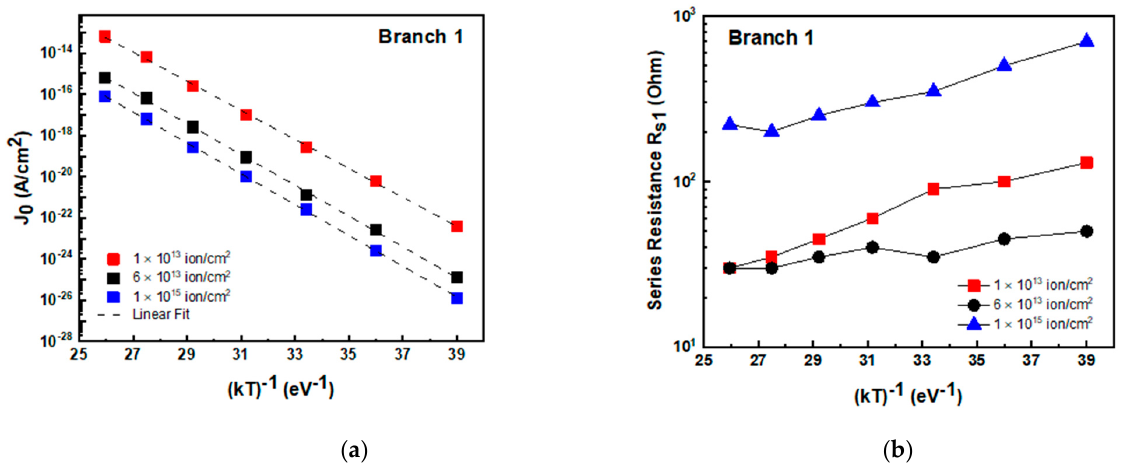
Figure 9. Pre-exponential factor J 0 for diode D 1 obtained by the fit of I–V characteristics as a function of 1/kT for high- fluence-irradiated diodes obtained by using the “parallel double diodes” structure (see text) ( a ). Series resistance R s1 versus 1/kT for branch 1 ( b ).